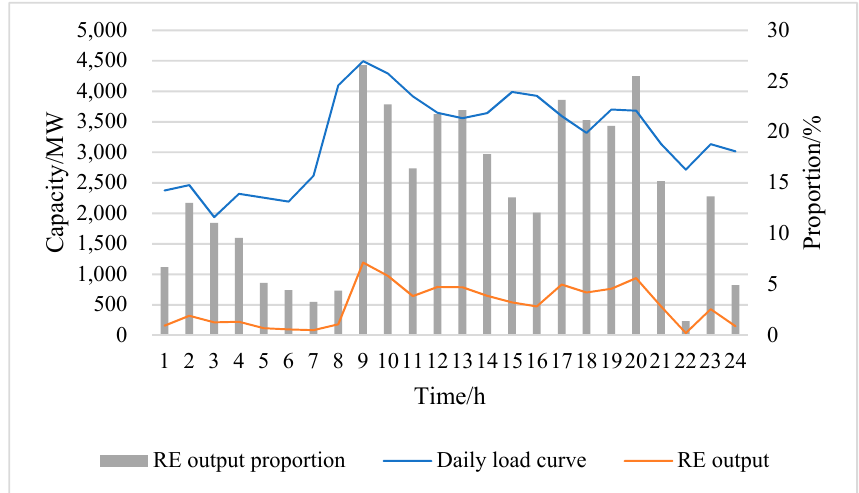
Figure 5. Modified load and new energy forecast curve.